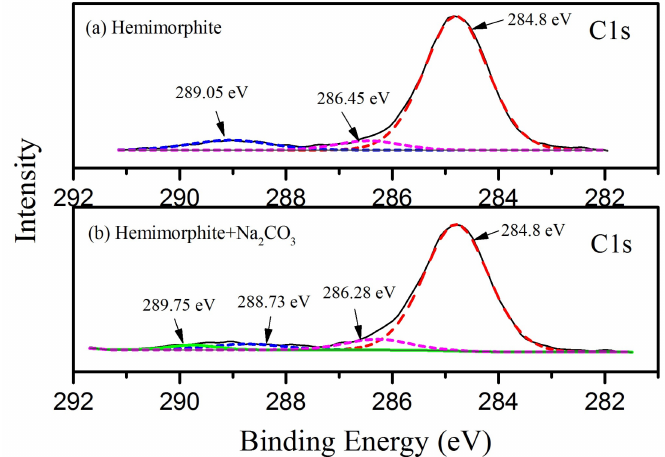
Figure 7. XPS Analysis for the treated and untreated hemimorphite with Na 2 CO 3 . ( a ) hemimorphite; ( b ) hemimorphite + Na 2 CO 3